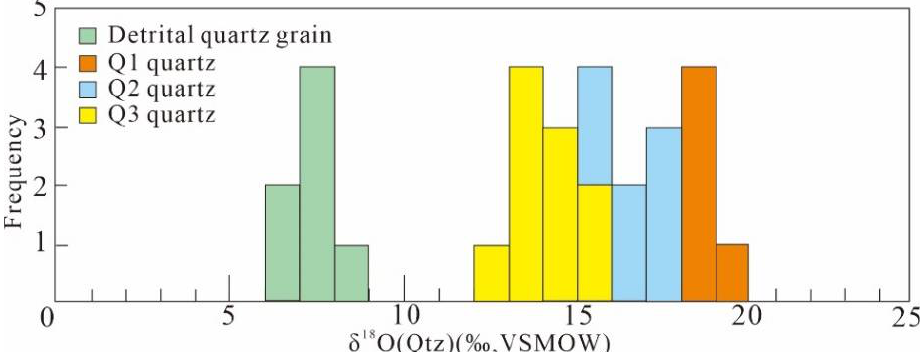
Figure 5. Histograms of the homogenization temperature (Th) in the different phases of the quartz cements in the Xu2 sandstones.